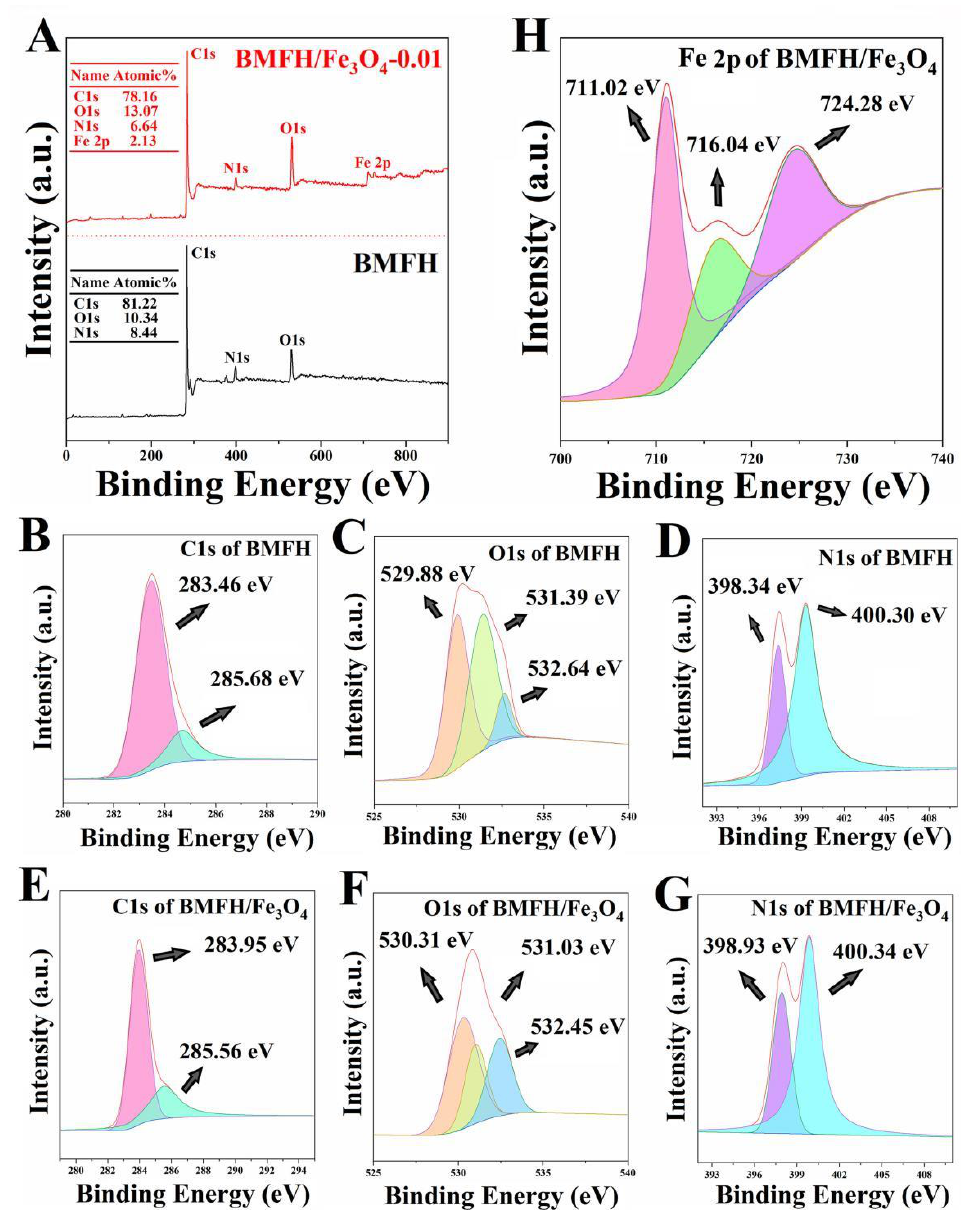
Figure 5. ( A ) XPS spectra of BMFH and BMFH/Fe 3 O 4 . The ( B ) C1s, ( C ) O1s, and ( D ) N1s of BMFH. The ( E ) C1s, ( F ) O1s, ( G ) N1s, and ( H ) Fe 2p of BMFH/Fe 3 O 4 .